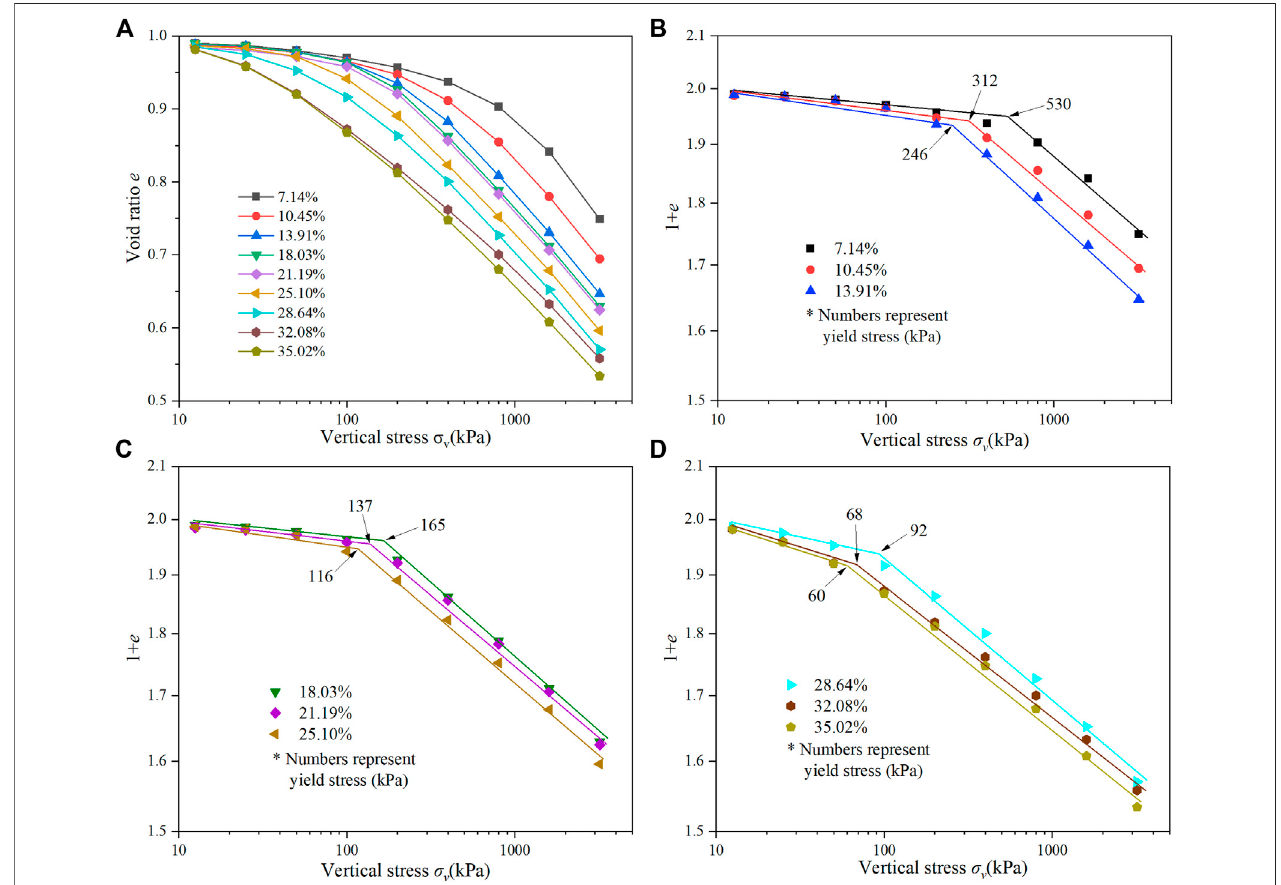
FIGURE 4 | Compression curve of intact loess at different water contents: (A) compression curves in an e -log σ v coordinate system; (B – D) compression curves in the ln (1 + e )-log σ v coordinate system.